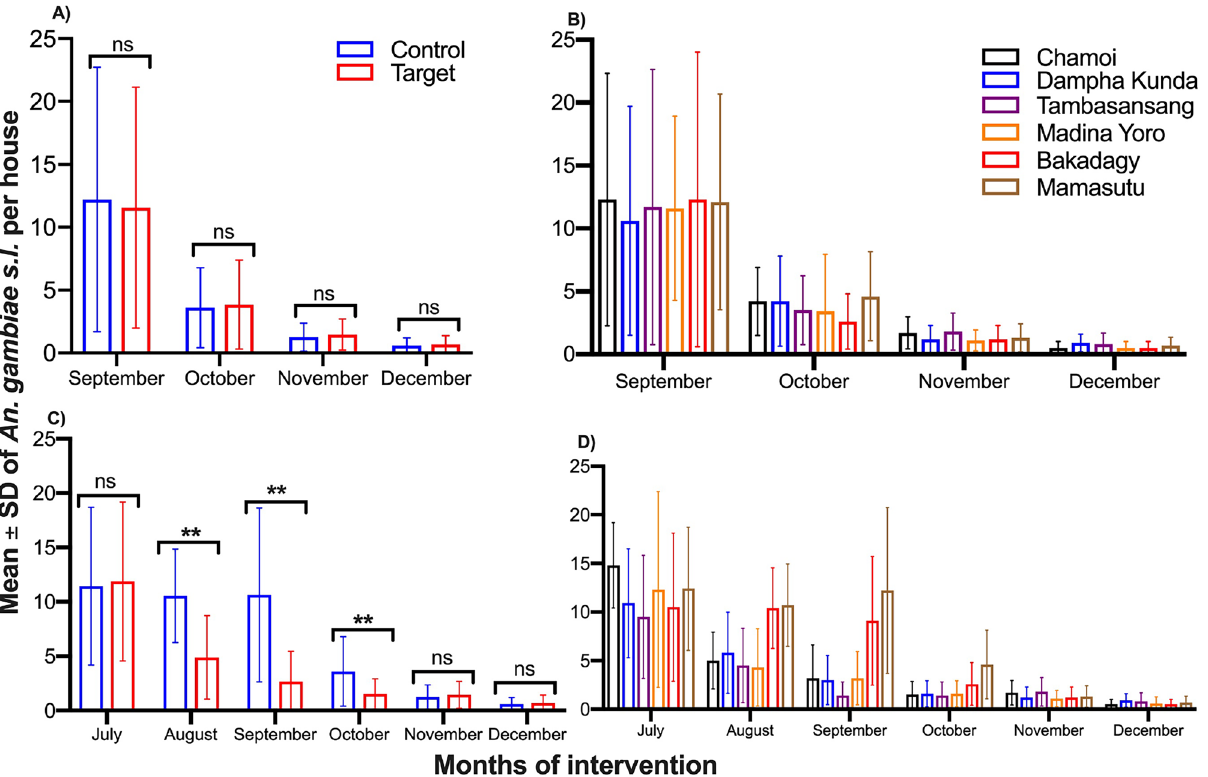
Figure 3. Anopheles gambiae s.l. density by study arm and village. Baseline vector density between September and December 2017 by study arm ( A ) and by village ( B ). Vector density during and after intervention(July– December 2018) by study arm ( C ) and by village ( D ).